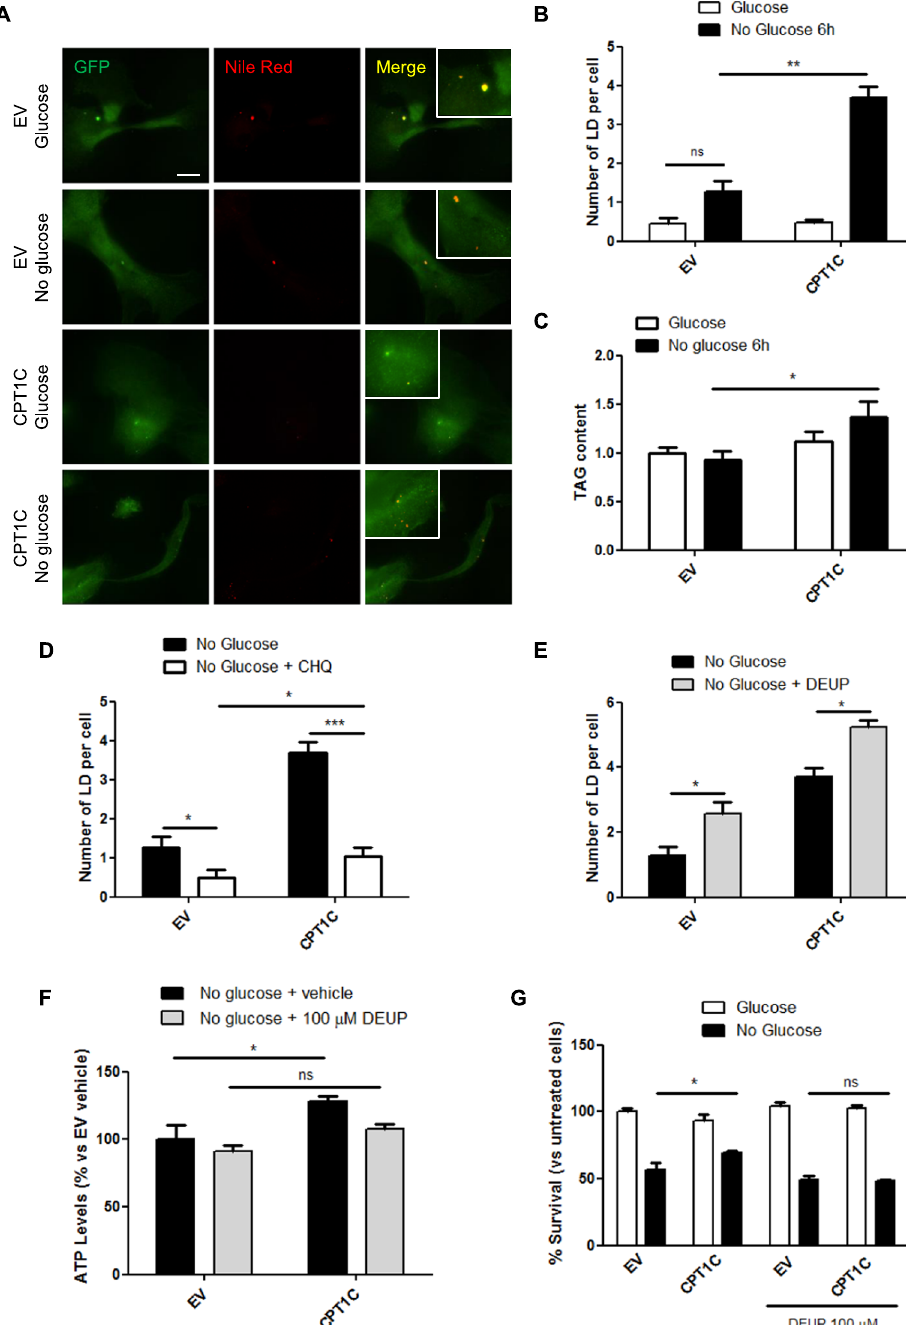
Figure 6. An increase in LD synthesis is essential to the CPT1C-mediated protector effect under glucose starvation. ( A ) Analysis of LD number and area in EV or CPT1C-hMSCs cultured with or without glucose for 6 h. Cells were stained with Hoechst (blue) or Nile Red (red). Representative images are shown in A. The number of LDs per cell ( B ) are shown as the mean ± SEM of 3 independent experiments performed in triplicate. ( C ) Triglyceride content was determined 6 h after glucose starvation. Relative values are the mean ± SEM of 4 independent experiments performed in triplicate. ( D – E ) EV or CPT1C-hMSCs were cultured in the absence of glucose (6 h) in the presence or absence of 100 µ M CHQ (D) or 100 µ M DEUP ( E ). Results are shown as mean ± SEM of 3 independent experiments performed in triplicate. ( F ) ATP levels were measured in EV or CPT1C-hMSCs under glucose deprivation (36 h) in the presence (last 24 h) or absence of 100 µ M DEUP. Results are shown as the mean ± SEM of 2 independent experiments performed in triplicate. ( G ) Cell viability was measured in EV or CPT1C-hMSCs in the presence or absence of glucose (72 h) with or without the addition of 100 µ M DEUP in the last 24 h. Cell survival results are shown as mean ± SEM of 4 independent experiments performed in sextuplet. * p < 0.05; ** p < 0.01; *** p <